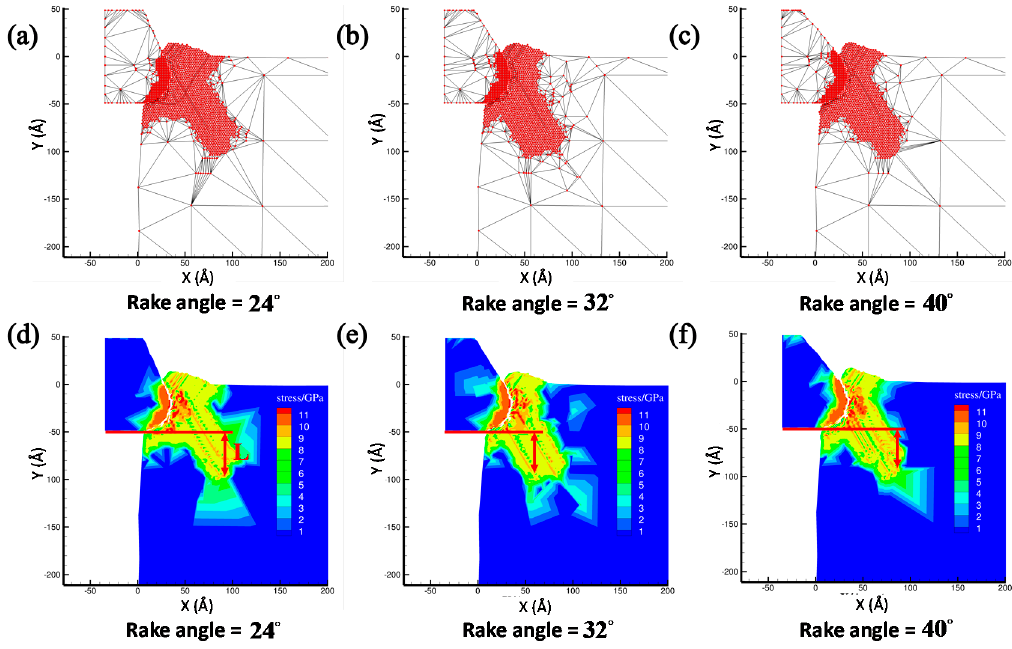
Figure 7. The atomic displacement and corresponding stress distribution at the 200th step by varying the tool rank angle from 24 to 40 ° . ( a ) The atomic displacement when the rake angle = 24 ° ; ( b ) the atomic displacement when the rake angle = 32 ° ; ( c ) the atomic displacement when the rake angle = 40 ° ; ( d ) the corresponding stress distribution when the rake angle = 24 ° ; ( e ) the corresponding stress distribution when the rake angle = 32 ° and ( f ) the corresponding stress distribution when the rake angle = 40 °.